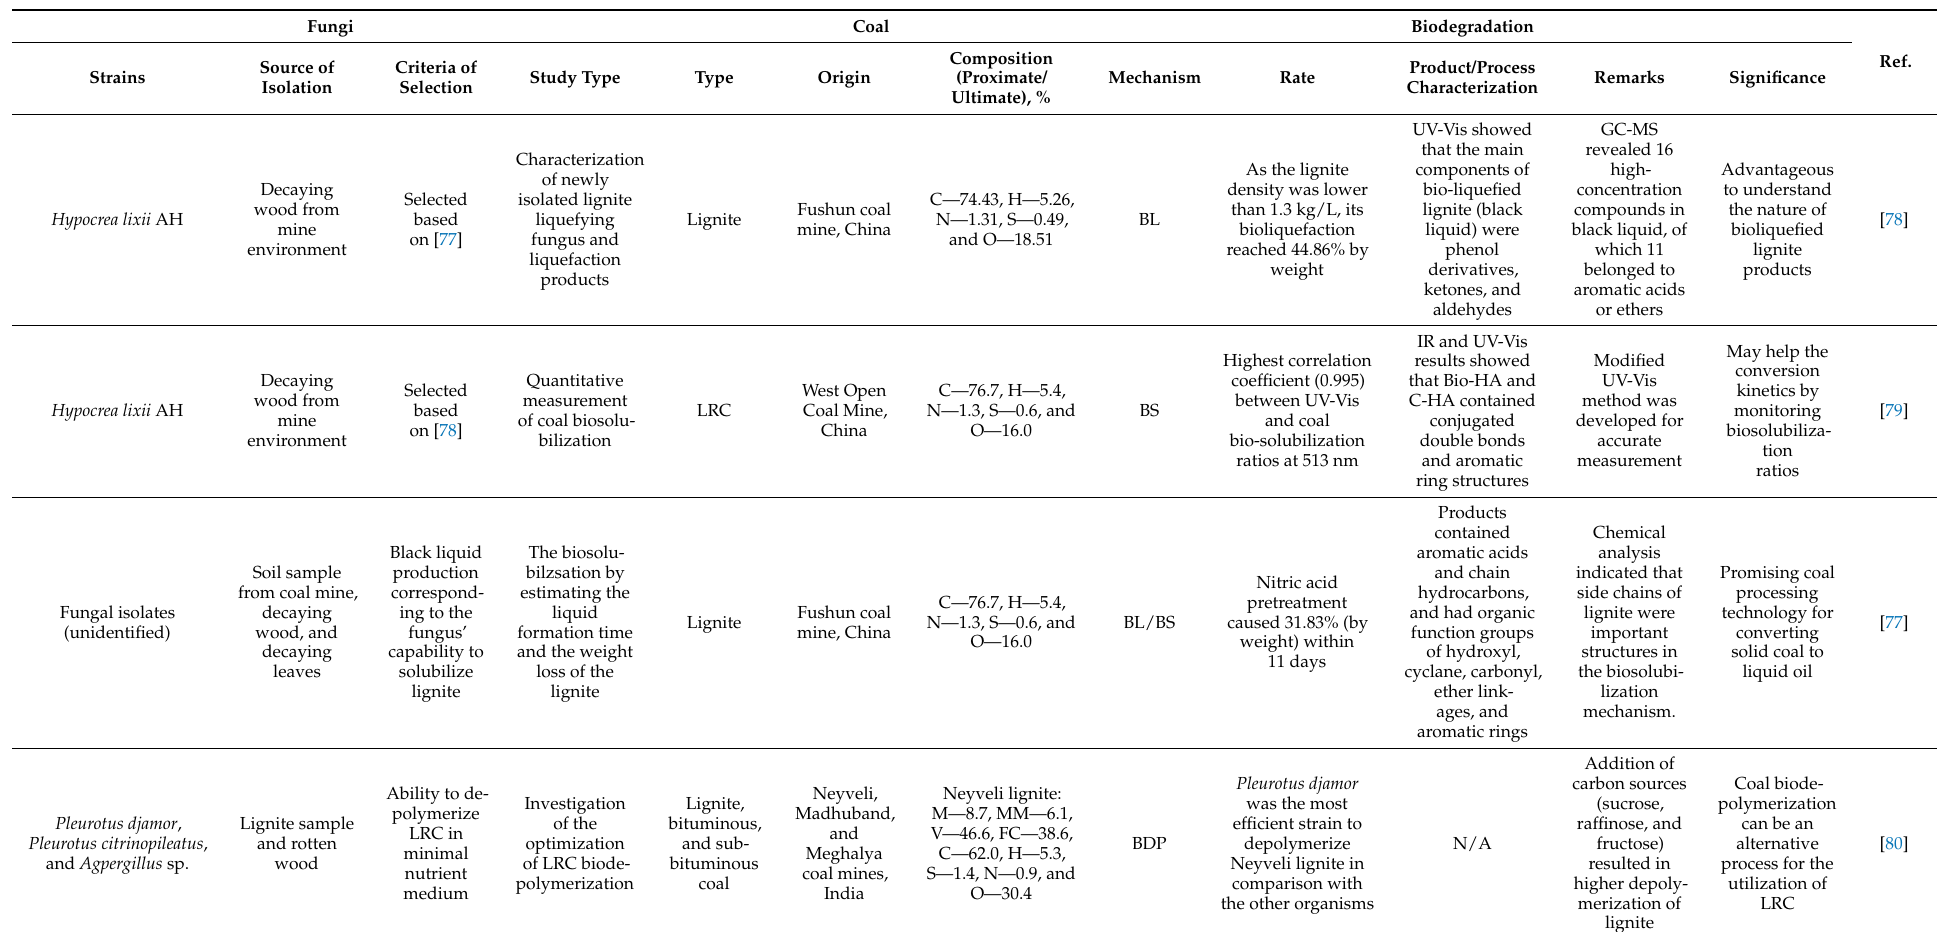
Table 3. Biodegradation of various coal sources through native strains of fungi: understanding the mechanisms, rates, and characterization of coal biodegradation is fundamental in the context of coal utilization/processing. This table considers only studies published since 2002